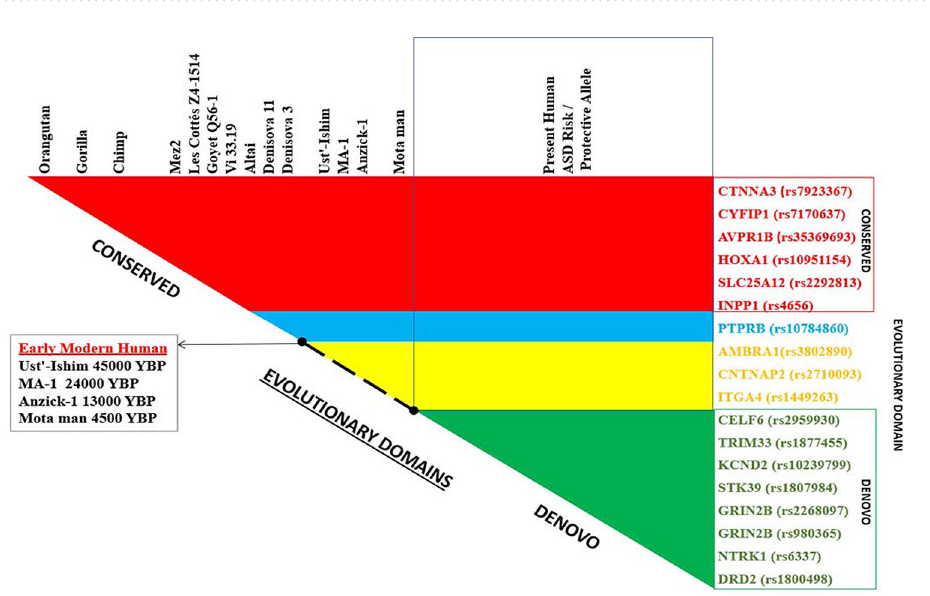
Figure 3. Protein–protein interaction networks. ( A ) STRING network showing genes harboring the positively selected SNPs (nearby genes for intergenic SNPs). ( B ) STRING network after including eQTL genes in the input list.